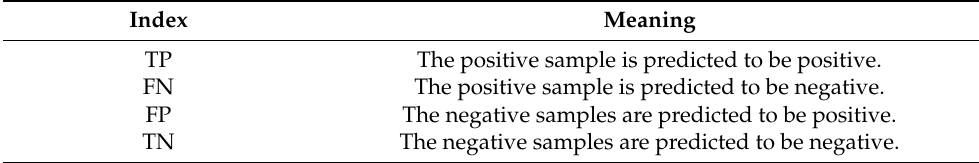
Table 3. The meaning of confusion matrix. Index Meaning TP The positive sample is predicted to be positive. FN The positive sample is predicted to be negative. FP The negative samples are predicted to be positive. TN The negative samples are predicted to be